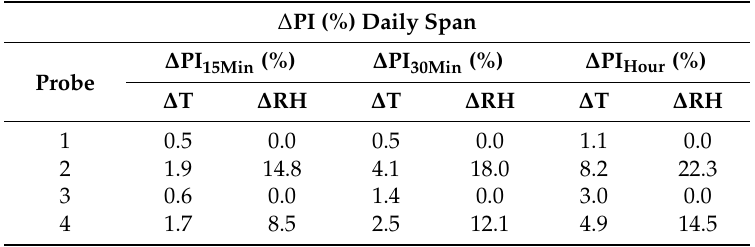
Table 6. Differences between reference PI MINUTE(daily span) values (Table 5) and PI obtained with datasets associated with extractions every 15 min, every 30 min and every hour. The Performance Index is defined as the percentage of T and RH daily fluctuations that fall inside the limit daily span recommended in the UNI 10829:1999 standard for the conservation of paper. The differences ∆ PI ∆ PI ∆ PI 15Min , 30Min , and Hour are calculated as (PI 15Min – PI MINUTE ), (PI 30Min – PI MINUTE ), and (PI Hour – PI MINUTE ),